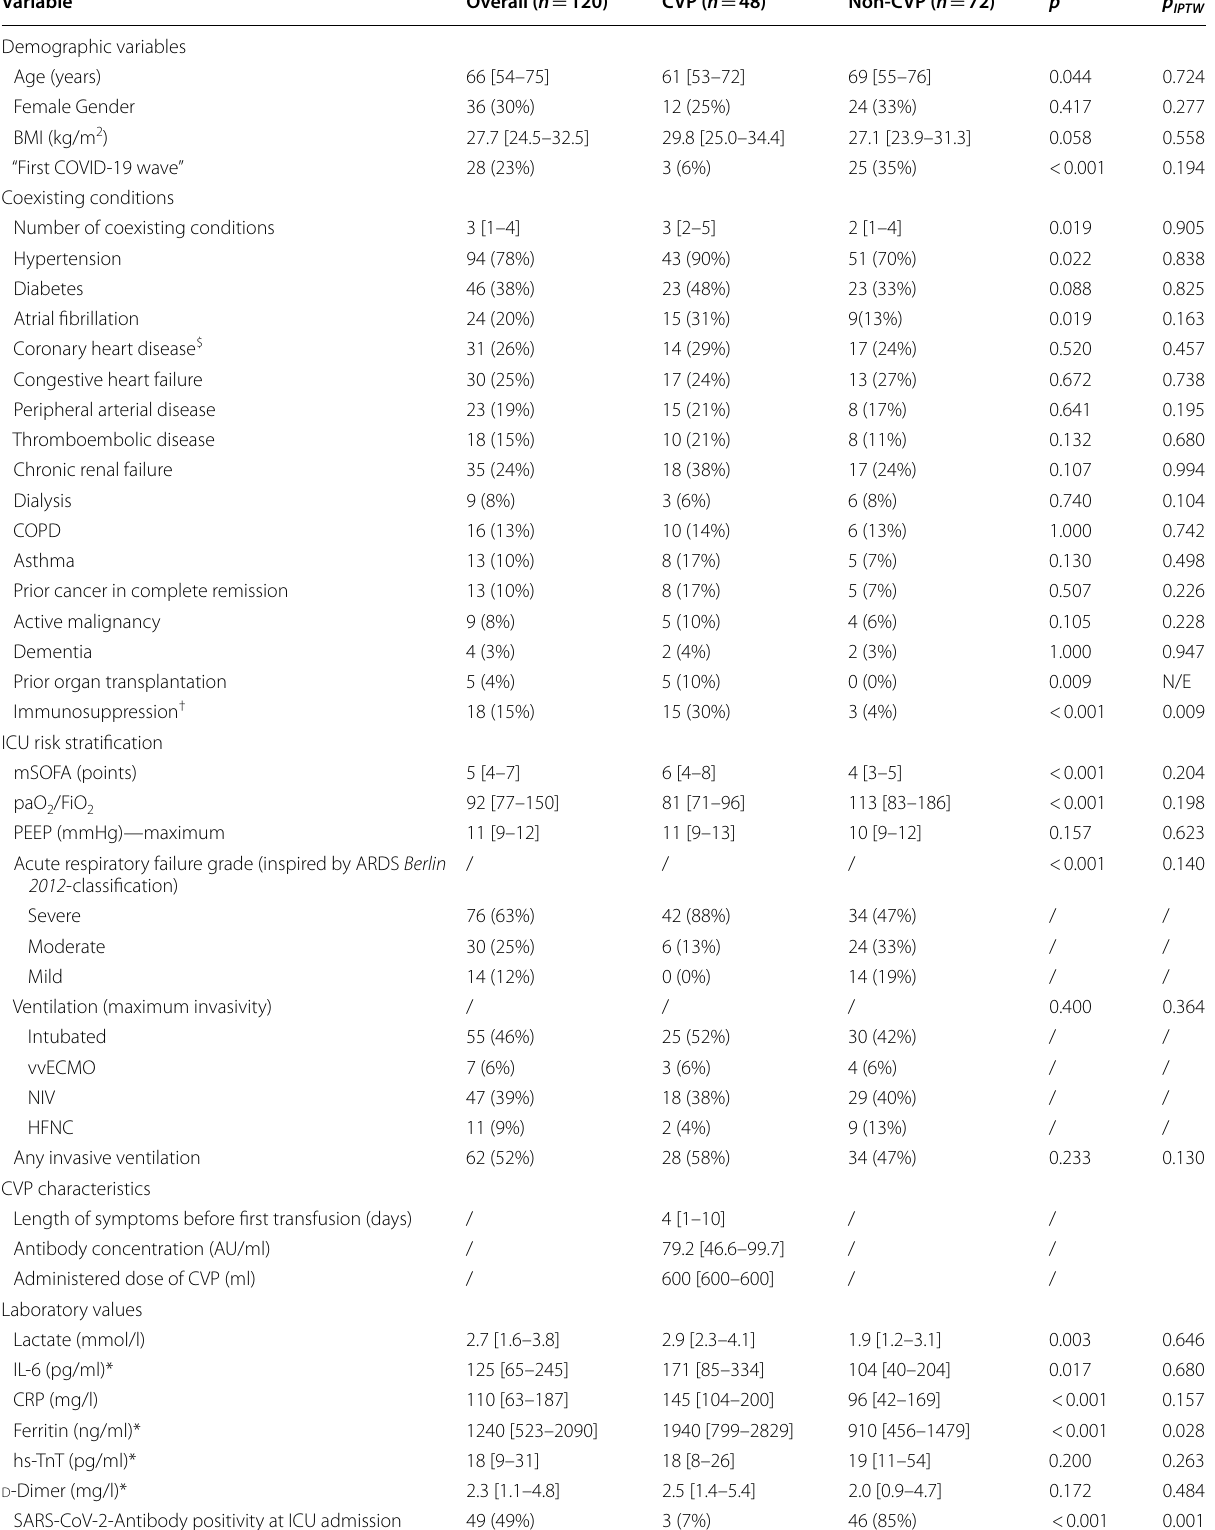
Table 1 Baseline characteristics of the study population—distribution at ICU